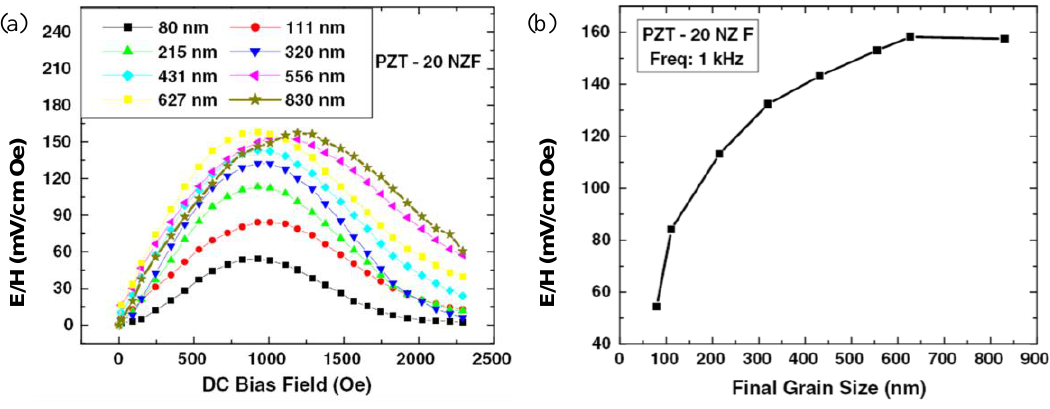
Figure 14. Magnetoelectric responses as a function of (a) DC bias field and (b) grain size of